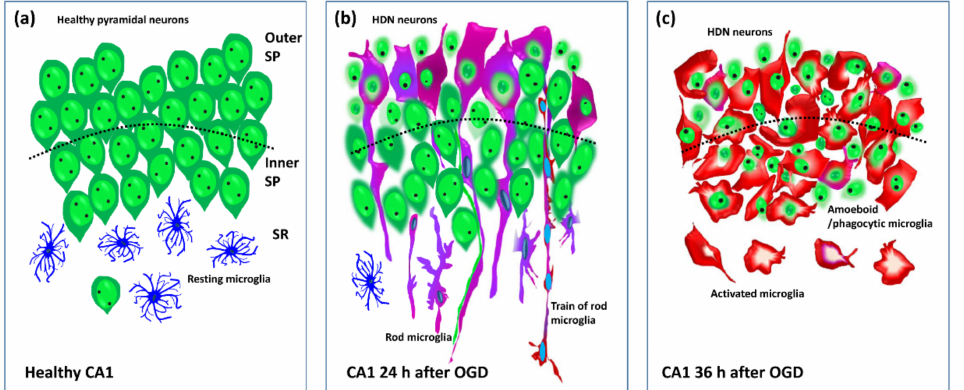
Figure 7. Schematic representation of the healthy CA1 hippocampus ( a ) and the morphofunctional modifications of microglia and neurons at 24 ( b ) and 36 h ( c ) after the OGD. Resting microglia (blue), activated rod microglia (pink-purple), amoeboid/phagocytic microglia (red). A train of rod microglia is shown ( b